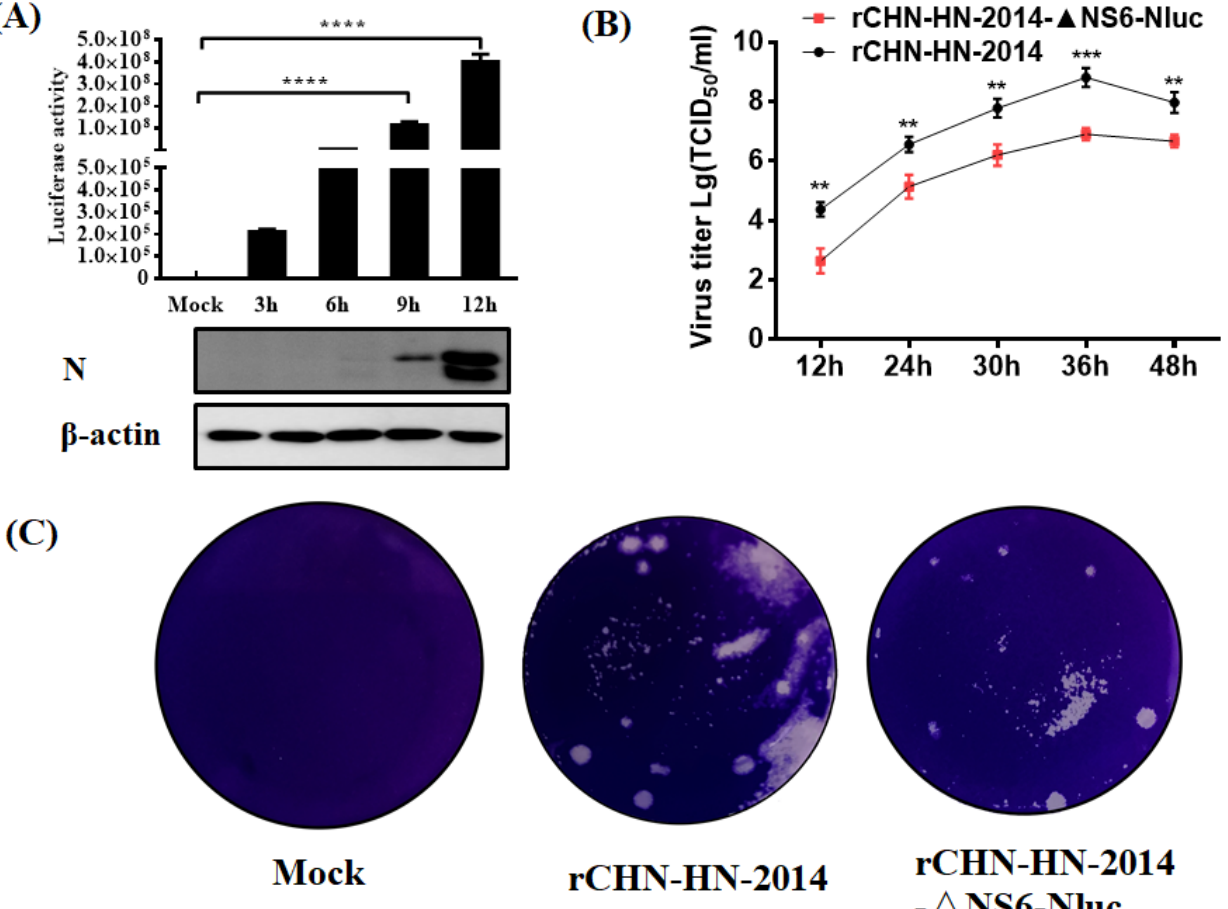
Figure 5. In vitro growth characterization of the Nluc reporter viruses. ( A ) Luciferase activity of rCHN-HN-2014- ∆ NS6-Nluc-infected cells. LLC-PK1 cells were infected with rCHN-HN-2014- ∆ NS6-Nluc, followed by harvesting infected cells at different time point and measuring luciferase activity. Experiments were carried out in triplicate. Collected cell lysates were subjected to Western blot assay using antibodies against N and β -actin. **** p < 0.0001. ( B ) Multiple-step growth curves of the rCHN-HN-2014 and rCHN-HN-2014- ∆ NS6-Nluc on LLC-PK cells. Cells were infected with recombinant PDCoVs at an MOI of 0.01, and cell supernatants were collected at the indicated time points post-infection, followed by TCID 50 assays on LLC-PK cells. ** p < 0.01; *** p < 0.001. ( C ) Mean plaques size of rCHN-HN-2014- ∆ NS6-Nluc in LLC-PK cells are smaller compared with that of rCHN-HN-2014.